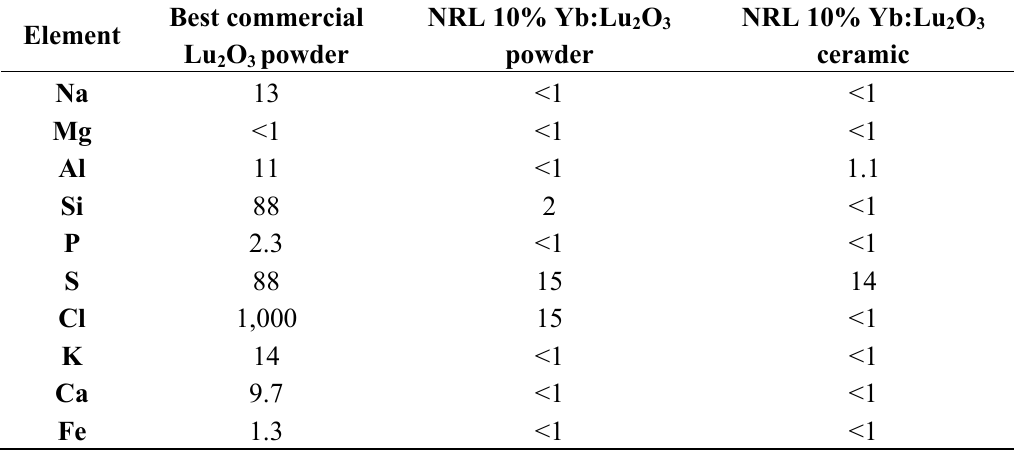
Table 3. List of the impurities measured, in ppm-wt, using glow discharge mass spectrometry (EAG Lab, North Billerica, MA, USA) for the best commercial powder, NRL’s (Naval Research Laboratory) co-precipitated powder, and a transparent ceramic made using NRL’s co-precipitated powder, respectively. Only impurities greater than 1 ppm-wt are reported.